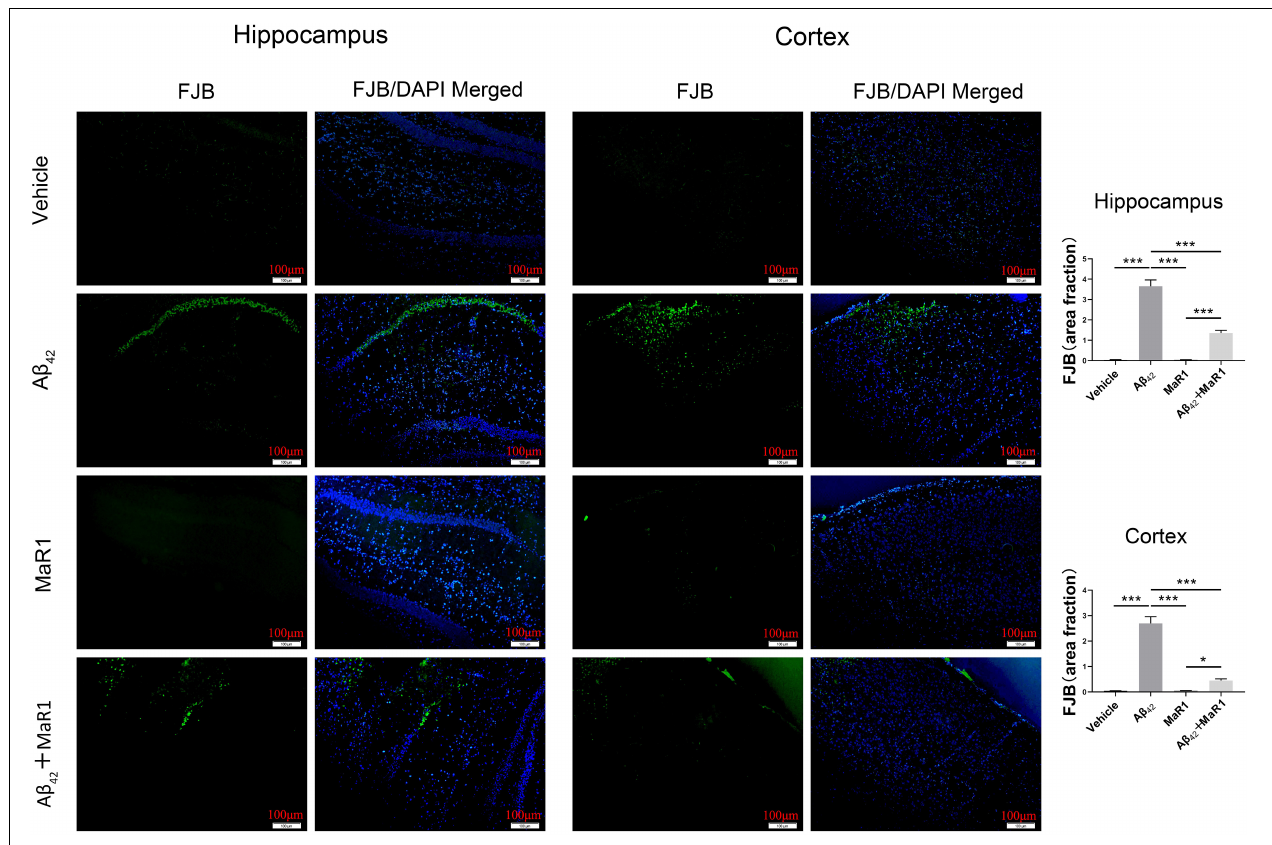
FIGURE 2 | FJB staining for neuronal degeneration in the hippocampus and cortex of AD mouse model. The higher number of degenerative neurons in A β 42 group than that in Vehicle group, and the number of degenerative neurons decreased in A β 42 + MaR1 group than that in A β 42 group ( P < 0.001). Scale bar = 100 µ m, Data are expressed as mean ± SEM, 10 mice in each group, and statistical significance is defined as follows: ∗ P < 0.05, ∗∗∗ P <